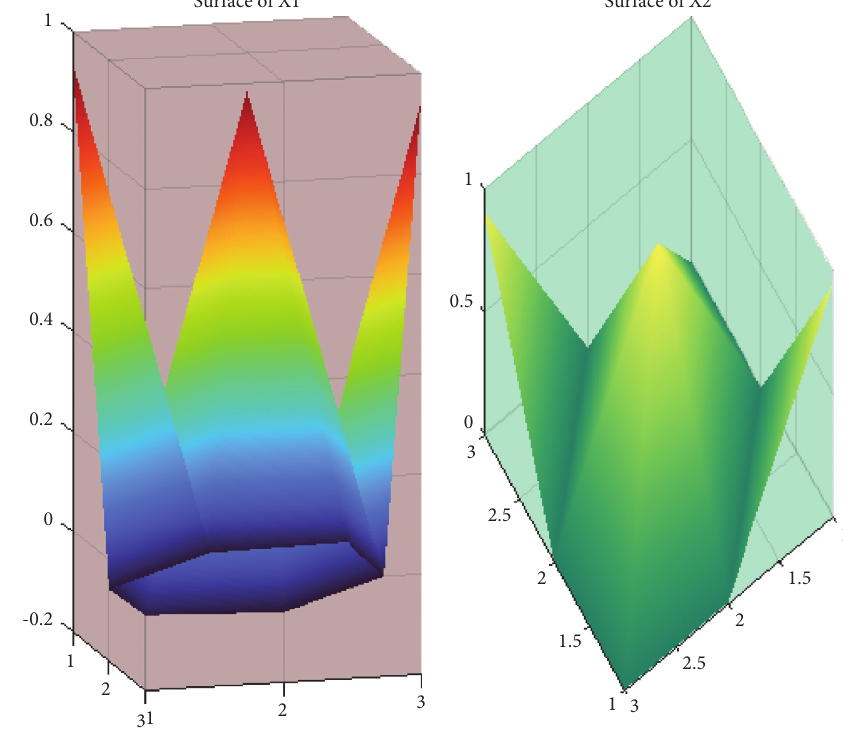
Figure 4: Solution surface